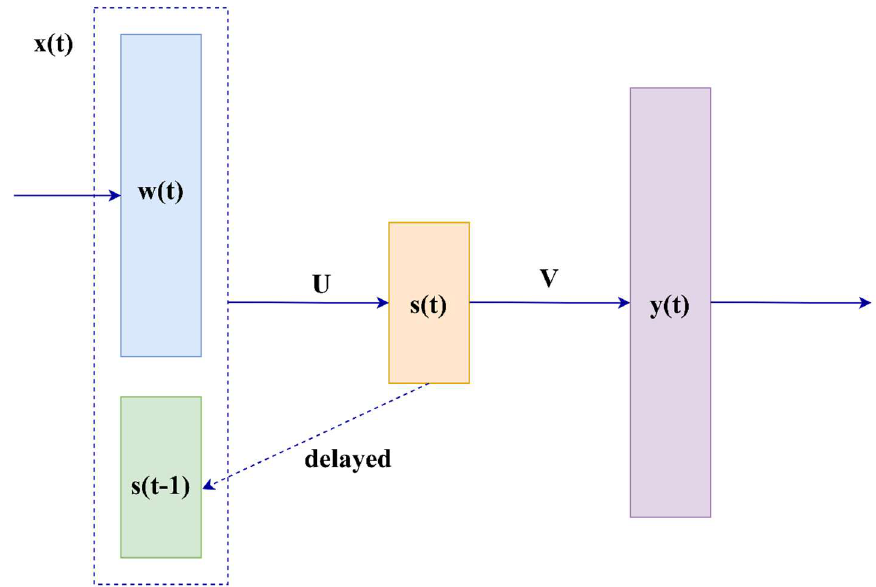
Figure 5. Architecture of language model based on recurrent neural networks.